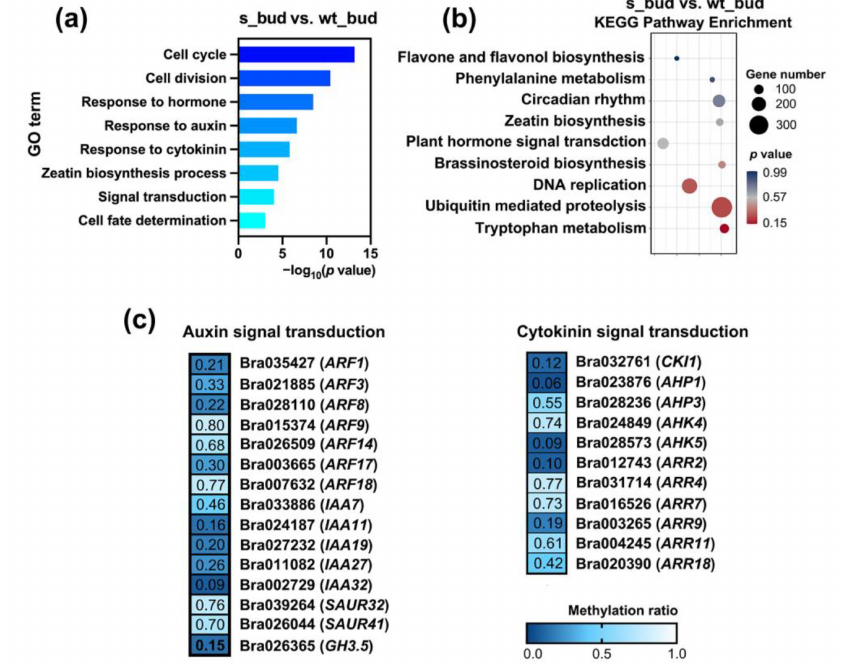
Figure 5. Functional analysis of DMGs in s_bud vs. wt_bud. ( a ) GO functional enrichment of the DMGs in s_bud vs. wt_bud. ( b ) KEGG pathway analysis of the DMGs in s_bud vs. wt_bud. ( c ) The methylation levels of auxin- and cytokinin-related DMGs in s_bud vs.